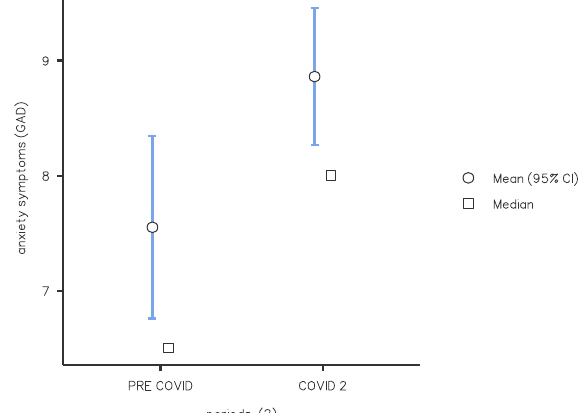
Figure 4. Anxiety symptoms: comparison of pre-COVID and COVID 2 periods. Mean score of the GAD-7 questionnaire for the screening of anxiety symptoms. Significance between pre-COVID and COVID 2 groups ( p = 0.012).